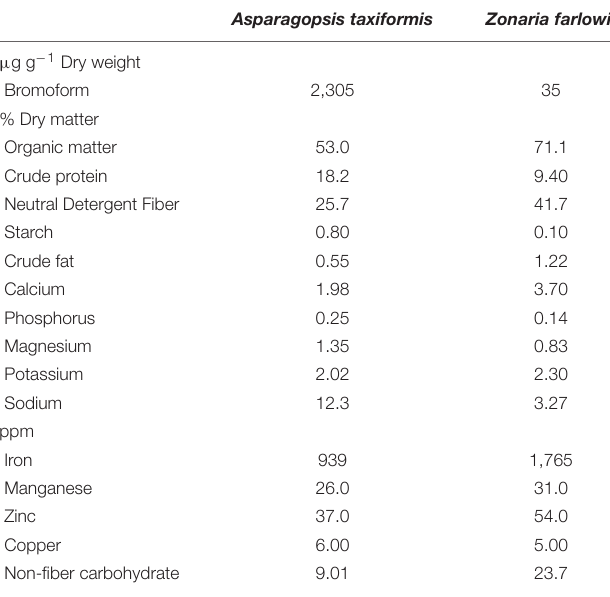
TABLE 1 | Biochemical composition of Asparagopsis taxiformis and Zonaria farlowii . Asparagopsis